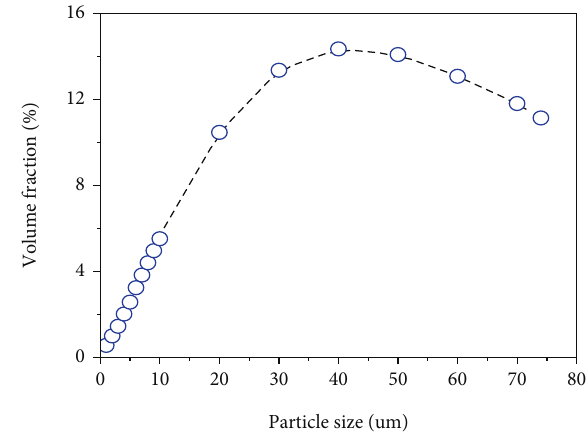
Figure 20: Tailing sand particles pass through steel mesh compared with original sample.